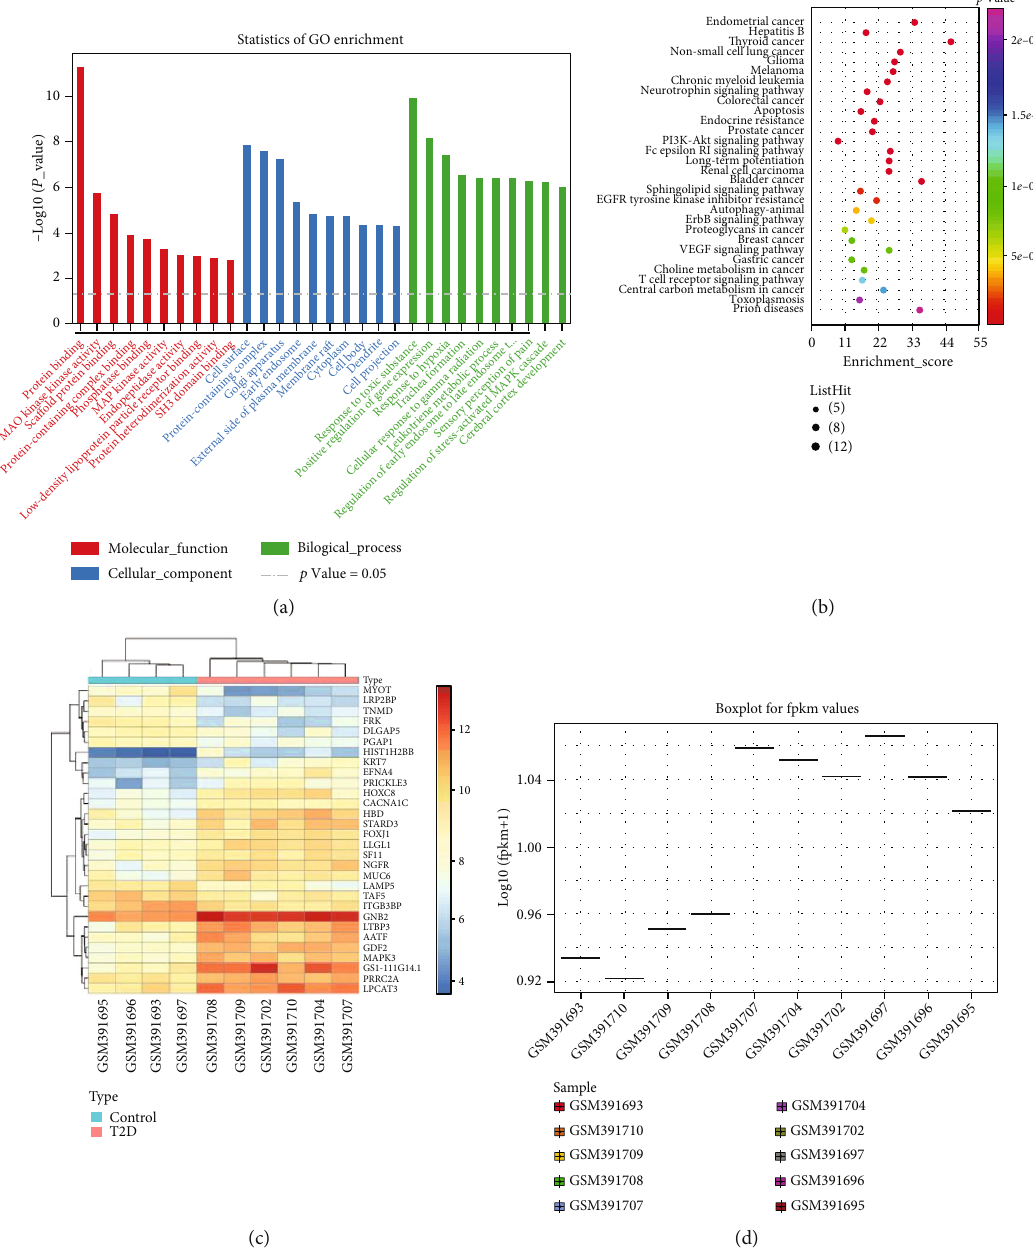
Figure 3: Secondary screening of core genes involved in the development of vascular damage in T2DM. (a) GO functional analysis of candidate DEGs at the BP, CC, and MF levels. (b) KEGG pathway enrichment analysis of candidate DEGs. Dot size indicated the number of selected genes, and color represented the p value for enrichment analysis. (c) Heat maps of candidate DEG expression matrix in di ff erent samples; the warmer the color of the block, the higher the expression. (d) MAPK3 expression in T2DM in